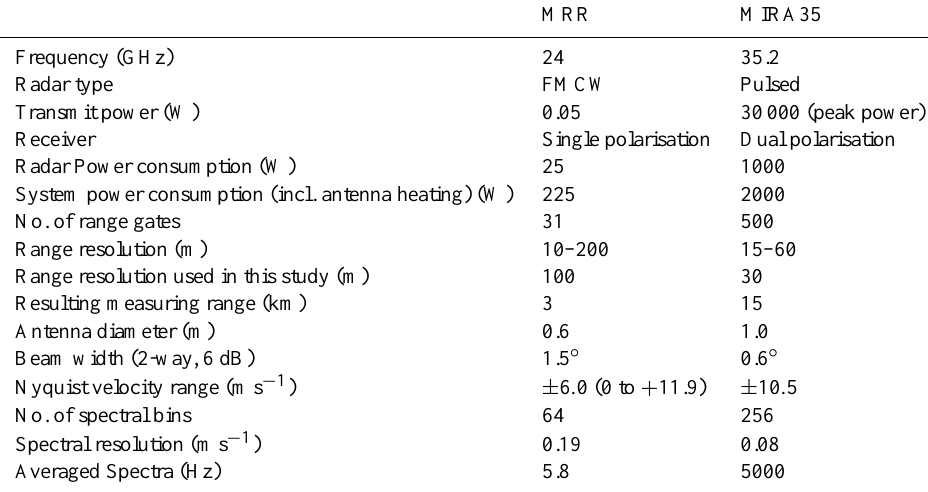
Table 1. Comparison of MIRA35 and MRR.